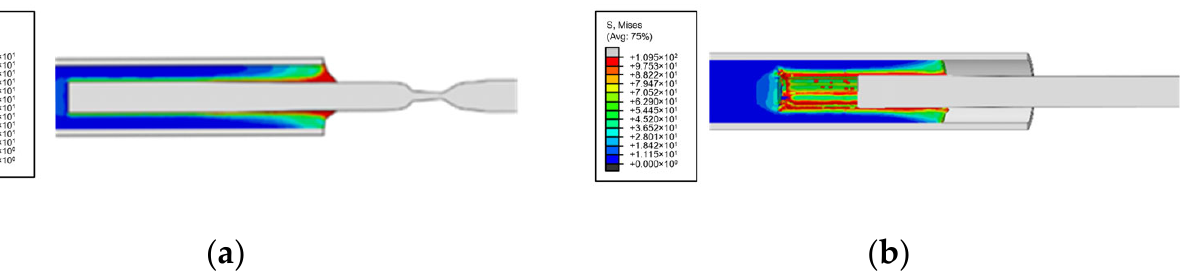
Figure 8. Grouting defect grid schematics. ( a ) Without defects. ( b ) With 25% defects at the end.